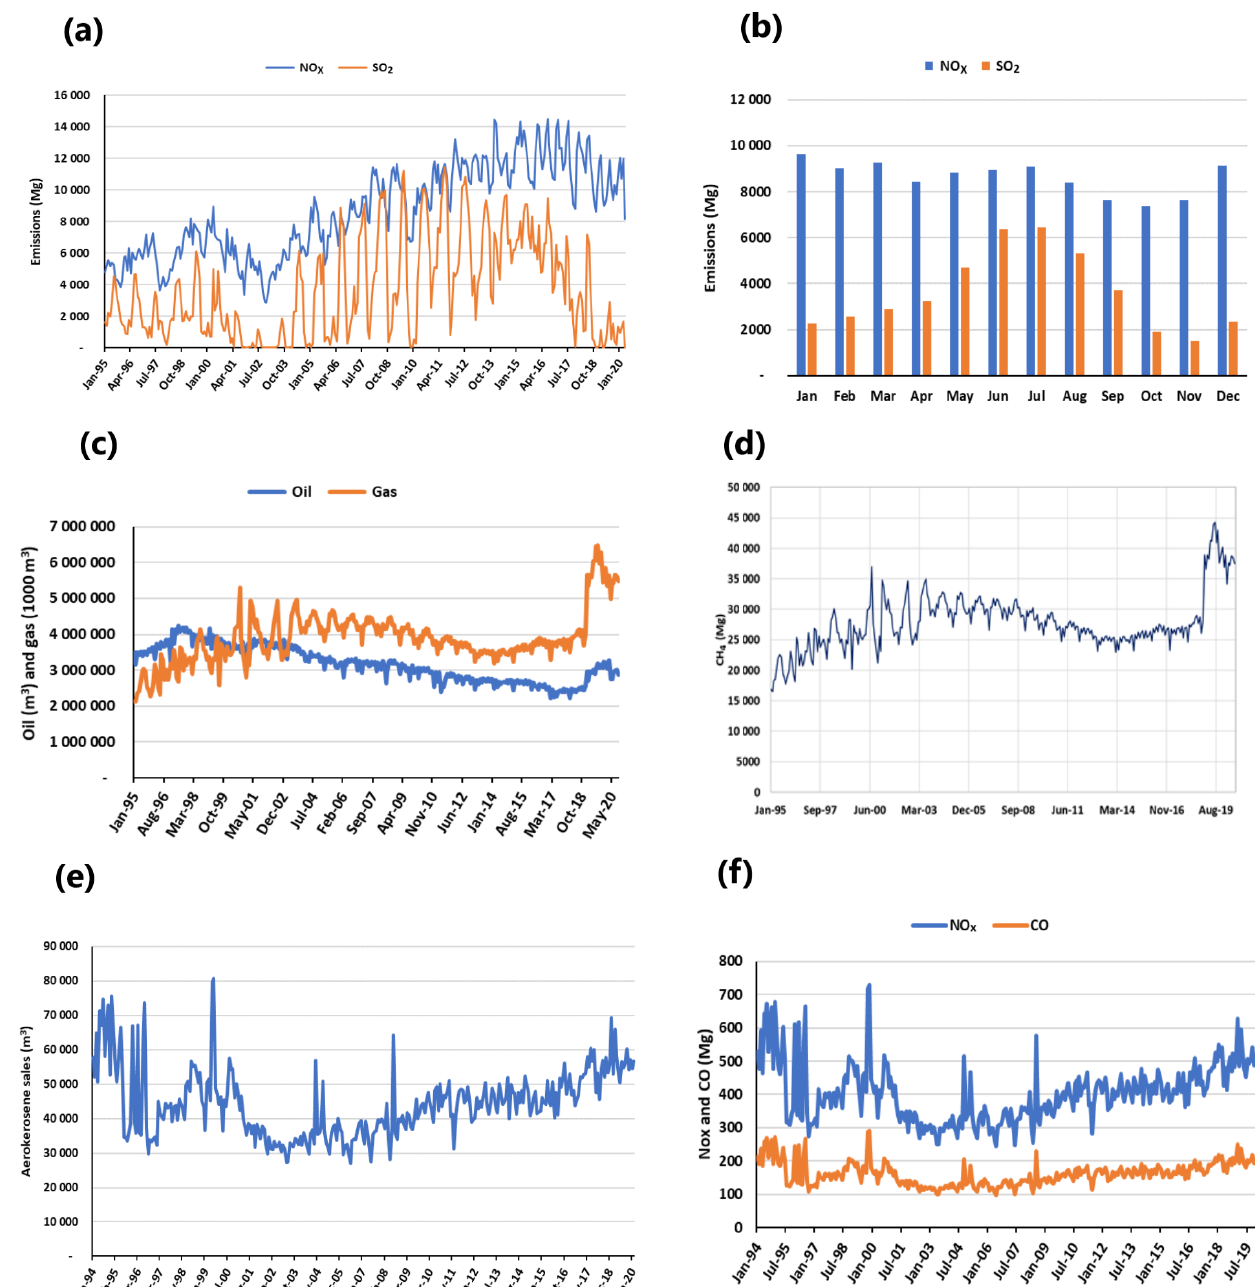
Figure A2. (a) Monthly NO x and SO 2 emissions (Mg) from thermal power plants. (b) Average seasonal NO x and SO 2 emissions 1995– 2019 (Mg) from thermal power plants. (c) Monthly oil (m 3 ) and gas production (1000m 3 ). (d) Monthly methane emissions (Mg) from fuel production. (e) Monthly aerokerosene sales at airports (m 3 ) for domestic and international flights. (f) Monthly CO and NO x emissions from aviation.